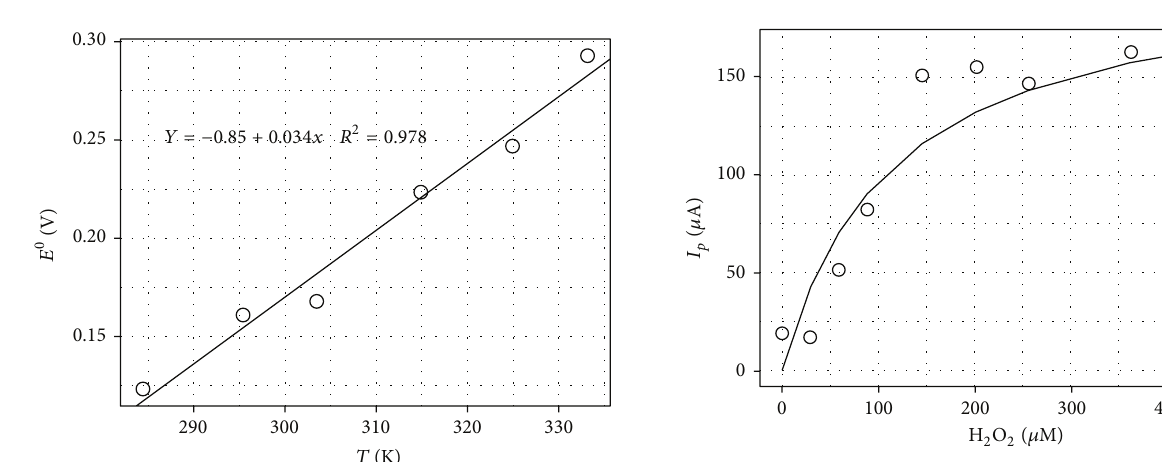
Figure 6: Temperature dependence of the redox potential of Mb/PMMA- b -PDMAEMA in phosphate buffer.